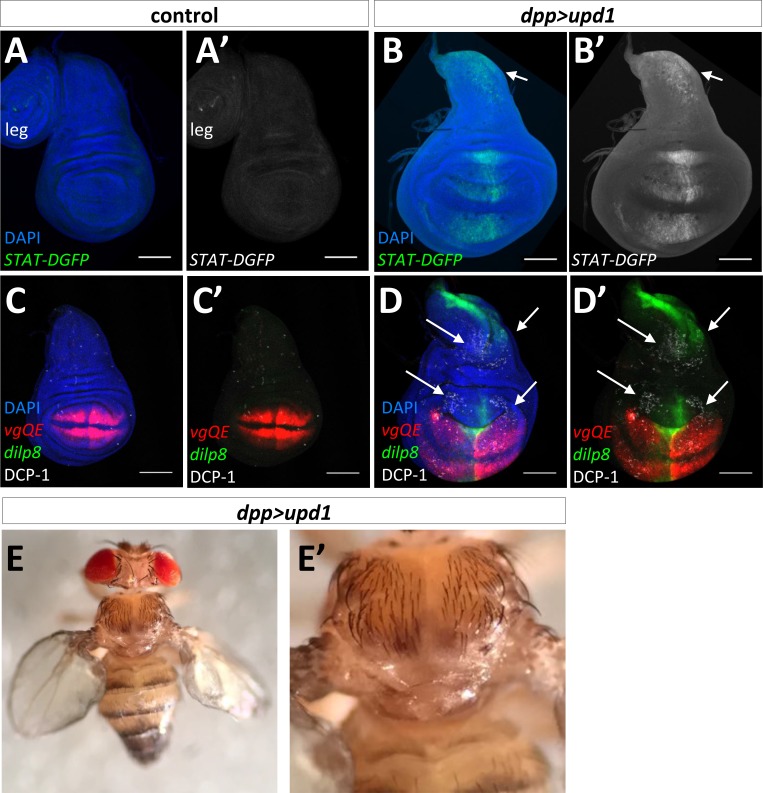
The notum and wing pouch respond to the overexpression of UAS-upd1 by dpp-GAL4.(A–B) JAK/STAT activity as shown by the STAT-DGFP reporter in late L3 wing discs in the control (A) and dpp>upd1 (B). Note the specific activation of STAT-DGFP in the notum and wing pouch but not in-between. (C–D) Apoptosis (DCP-1) in control (C) and dpp>upd1 (D) wing discs, with the dilp8-GFP reporter and a wing pouch reporter (vestigial quadrant enhancer, vgQE-RFP). Note the increase in DCP-1 staining following the overexpression of UAS-upd1, which is mostly adjacent to the areas of dilp8-GFP expression (arrows). (E) The adult phenotype of dpp>upd1. Note the disruption of the thorax including the loss of many bristles and macrochaetes.